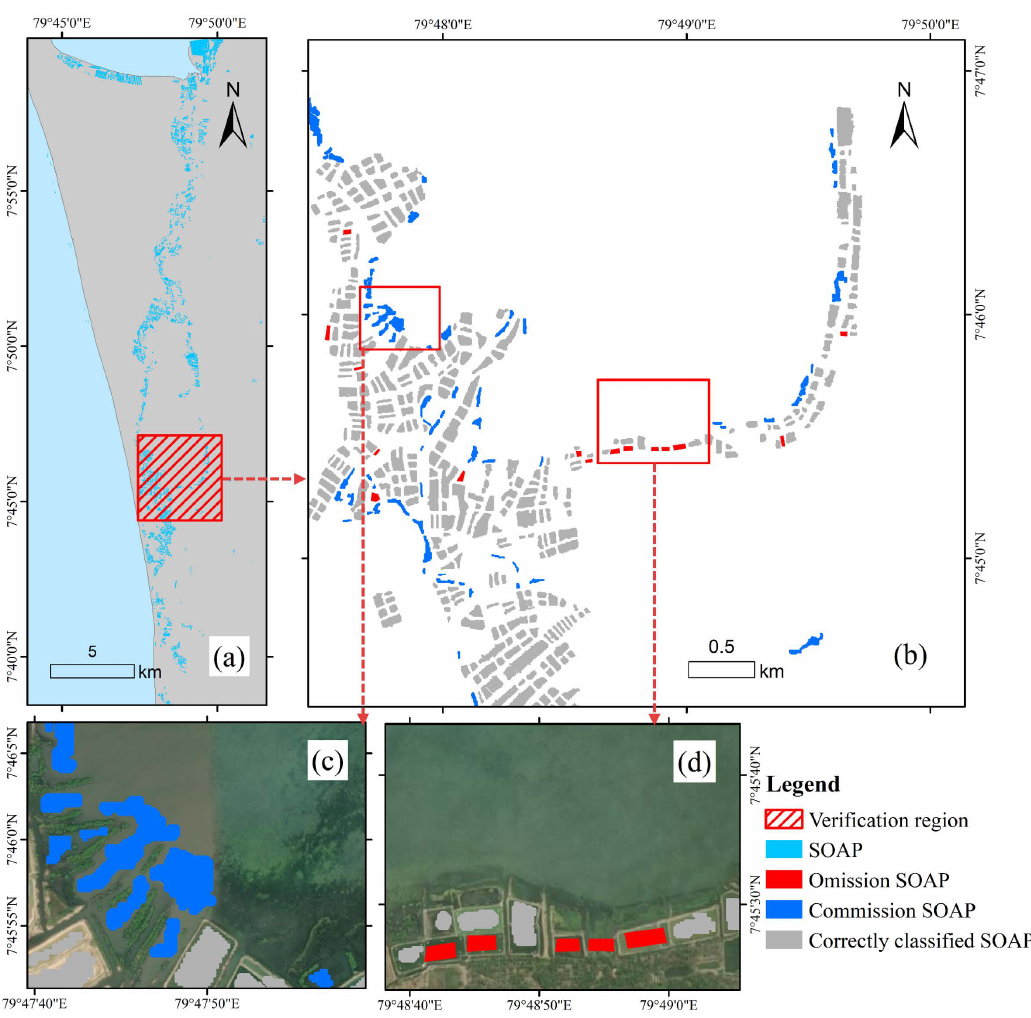
Figure 10. Comparison between extracted SOAPs and labeled SOAPs: ( a ) location of the verification region; ( b ) distribution of omission and commission SOAPs; ( c ) example of commission SOAPs; ( d ) example of omission